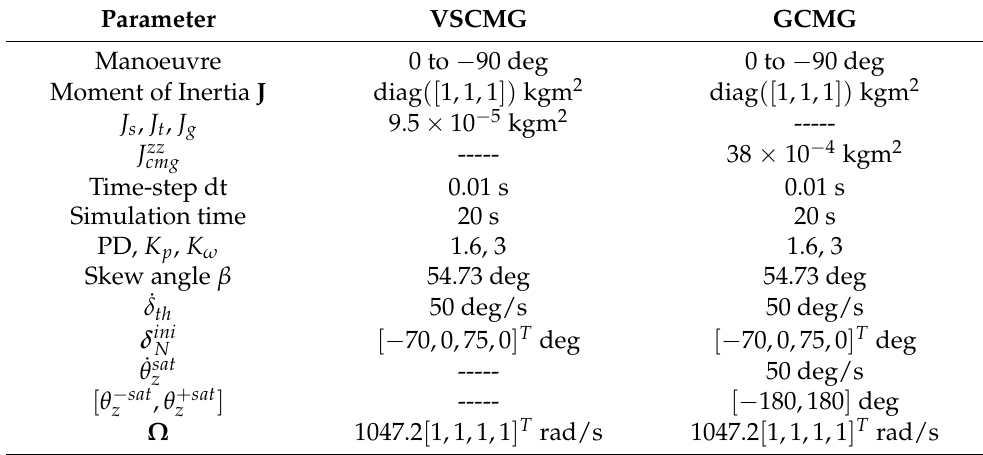
Table 1. Simulation